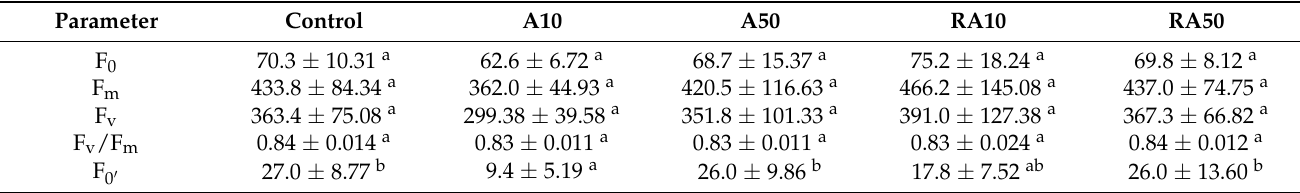
Table 5. Effects of A and RA treatments on chlorophyll a fluorescence. Different letters mean significantly different values ( p <